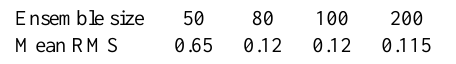
Table 1. Time average of the root mean square deviation of the log- arithm of phase space densities averaged over the entire simulation domain ( E , α eq , L ∗ ) versus the size of the ensemble. Ensemble size 50 80 100 200 Mean RMS 0.65 0.12 0.12